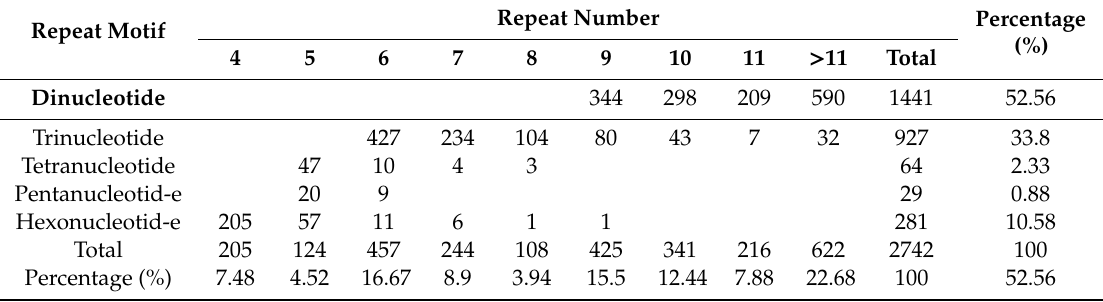
Table 2. Frequency of di ff erent repeat motifs of SSRs in the transcriptome of L.